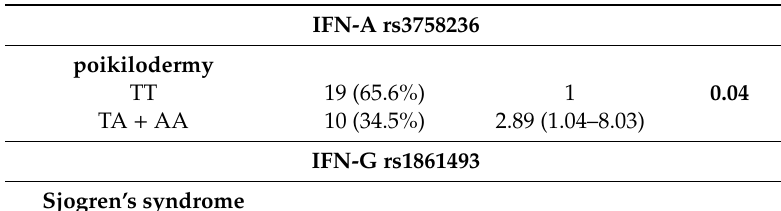
Table 6. Correlation between IFN-A, IFN-B, IFN-G genotypes (dominant model), and clinical pathology parameters in